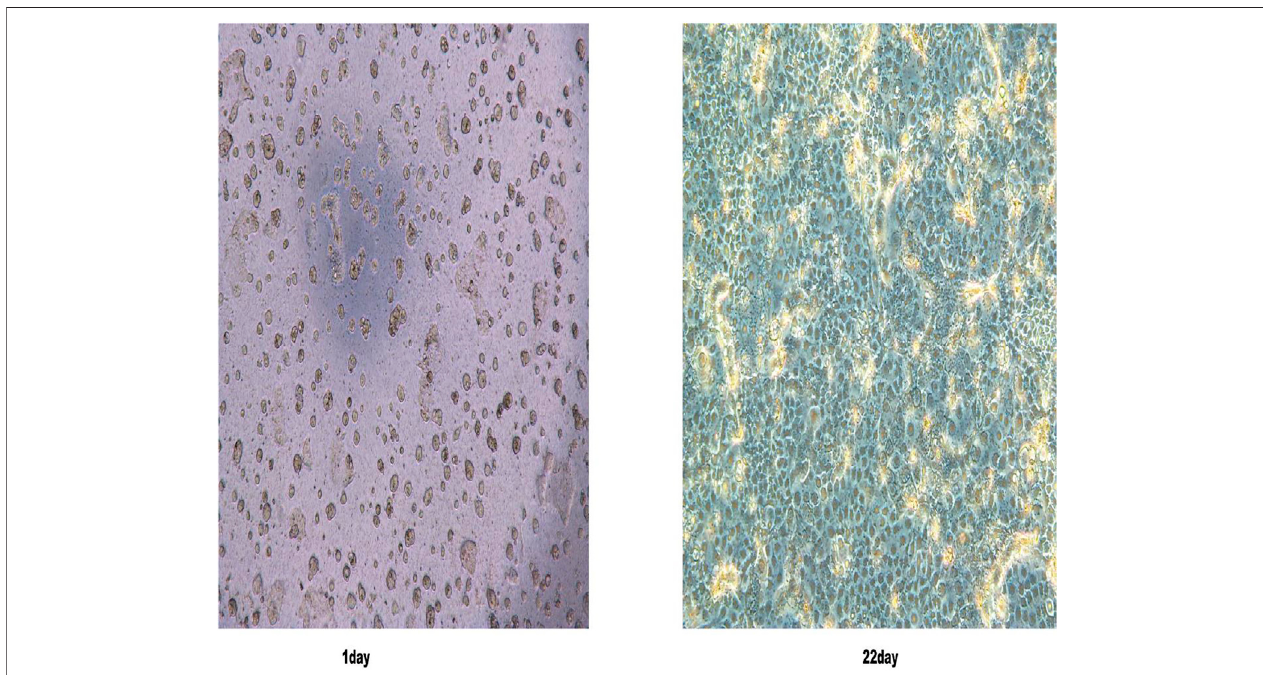
FIGURE 2 | Caco-2 cell morphology was observed under an inverted light microscope on the fi rst and 22nd